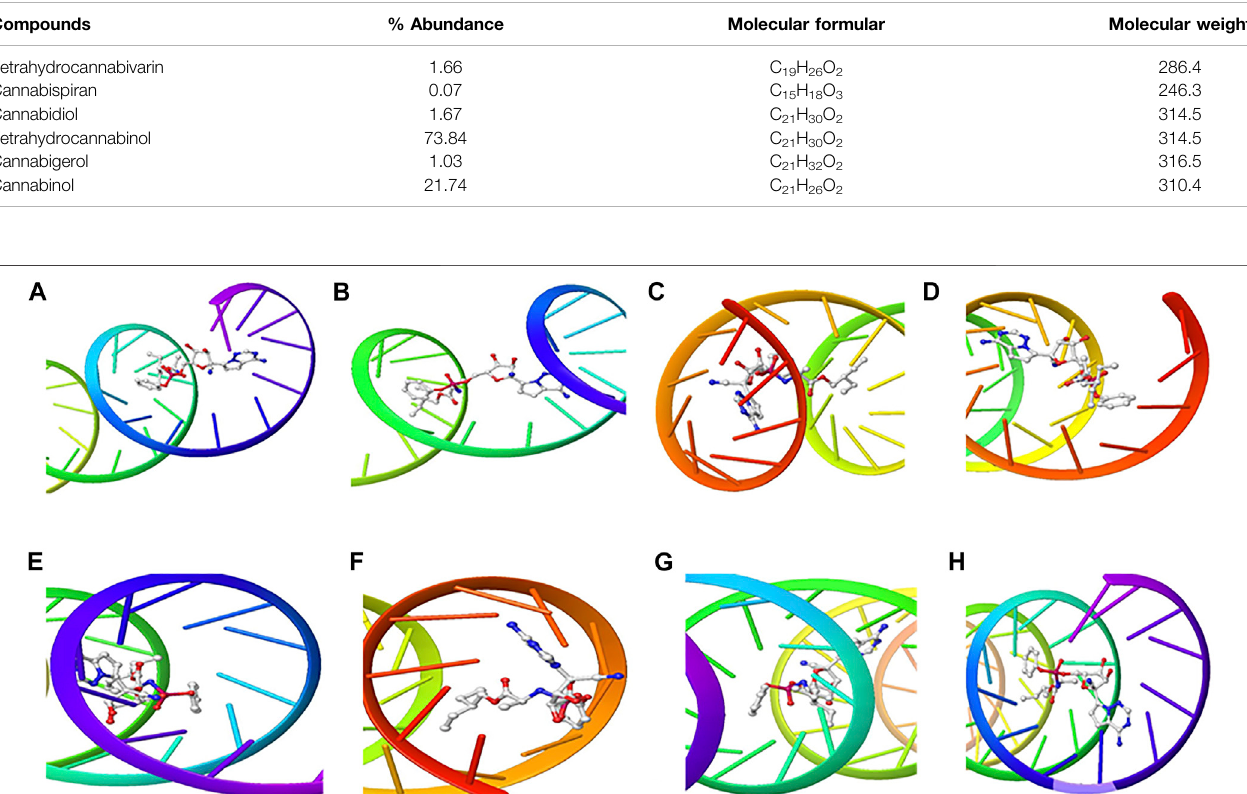
FIGURE3| 3DInteractionofRemdesivirwithInitiationandTerminationSequenceoftheViralProteins.A (cid:1) NucleocapsidPhosphoproteinTranslationInitiationSite; B (cid:1) Envelope Protein Translation Initiation Site; C (cid:1) Envelope Protein Translation Termination Site; D (cid:1) Nucleocapsid Phosphoprotein Translation Termination Site; E (cid:1) ORF1abTranslationInitiationSite;F (cid:1) ORF1abTranslationTerminationSite;G (cid:1) SurfaceGlycoproteinTranslationTerminationSite;H (cid:1) SurfaceGlycoproteinTranslation Initiation